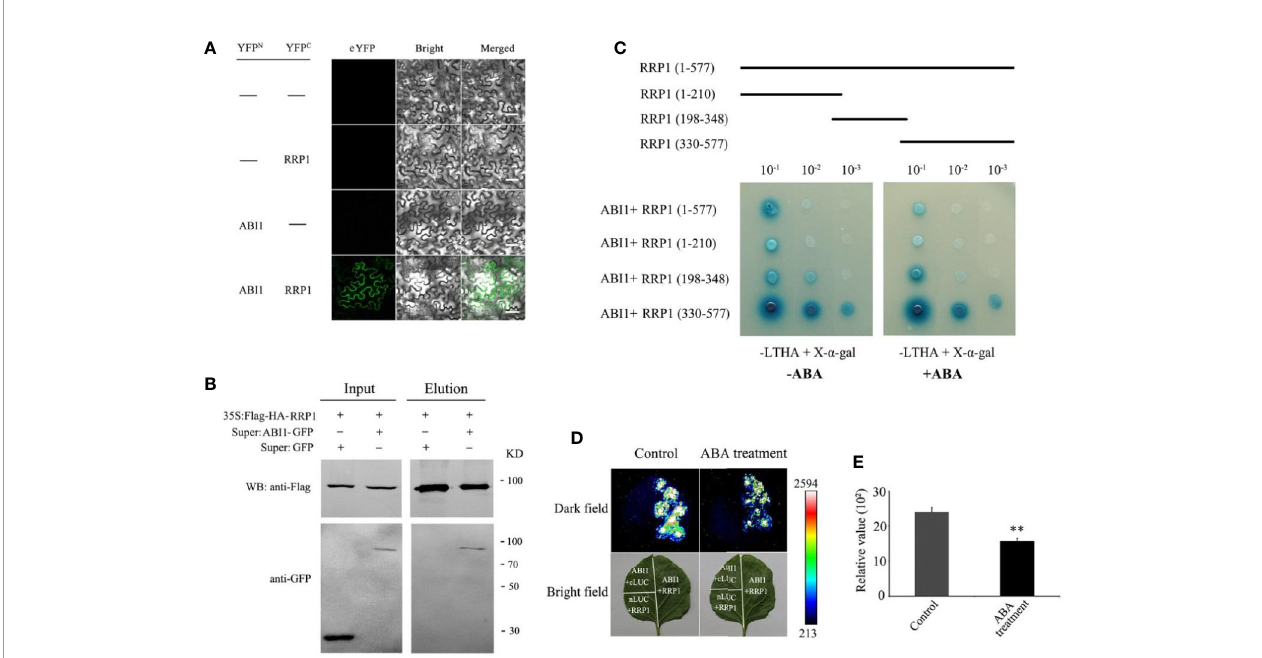
FIGURE 5 | Interaction of RRP1 with ABI1 in Arabidopsis and the in fl uence of ABA. (A) Bimolecular fl uorescence complementation (BiFC) assay showing the interaction of RRP1 and ABI1. eYFP, enhanced yellow fl uorescent protein. YFP N and YFP C are the N terminus and C terminus of eYFP, respectively. Scale bars, 20 m m. (B) Co- immunoprecipitation (Co-IP) assay of RRP1 with ABI1. Super : RRP1-GFP and 35S:Flag-HA-ABI1 , or Super : GFP and 35S:Flag-HA-ABI1 were co-transfected into Arabidopsis protoplasts. Co-IP was conducted with anti-Flag beads from total isolated proteins, and immunoblotting analysis was performed with anti-GFP and anti-Flag antibodies. (C) The C-terminus of RRP1 primarily interacts with ABI1, and ABA weakens RRP1 – ABI1 interaction in a Y2H assay. Top panels show a schematic representation of the different RRP1 deletions in the yeast vectors. Yeast transformants were spotted onto the selective medium SD/ − Leu/ − Trp/ − His/ − Ade ( − LTHA)/+X- a -gal supplemented with 0 or 40 m M ABA. (D) ABA weakens RRP1 – ABI1 interaction in a fi re fl y luciferase (LUC) complementation imaging system. Nicotiana benthamiana leaves were transformed with the construct pairs ABI1-nLUC/RRP1-cLUC and negative controls (ABI1-nLUC/cLUC and nLUC/RRP1-cLUC). The leaves were observed for fl uorescence imaging 6 h after spraying 0 or 100 m M ABA on the infected leaf surface. (E) Quantitative analysis of luminescence intensity. Each value is the mean ± SE of three independent experiments. Asterisks indicate statistically signi fi cant differences compared with the control: **, P <